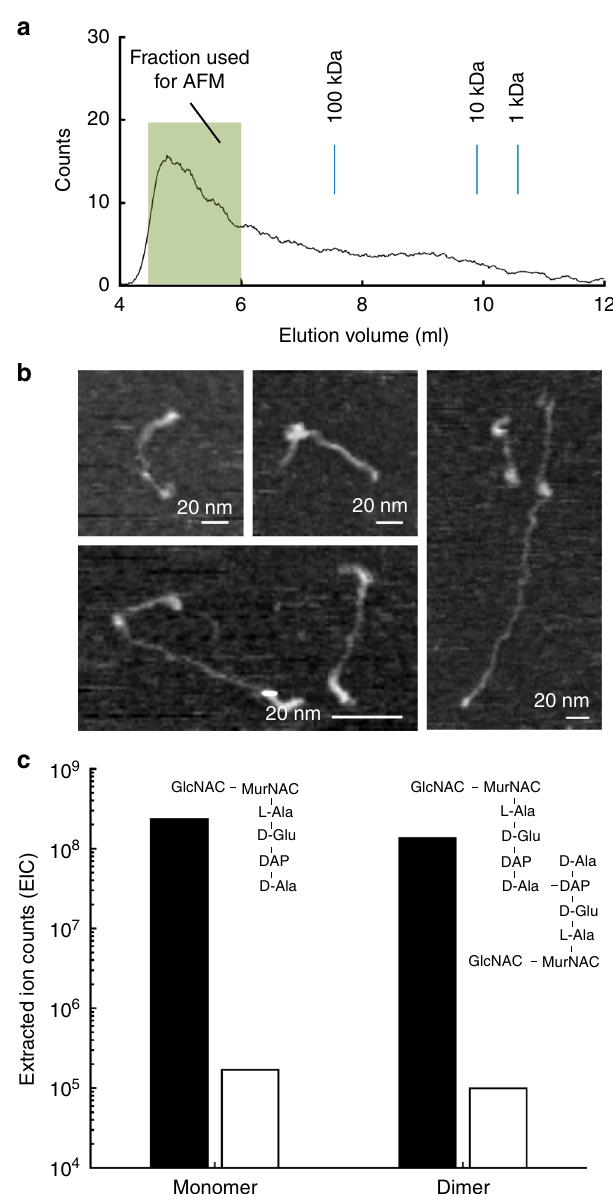
Fig. 3 Size exclusion chromatography and AFM imaging of isolated glycan strands. a Size exclusion chromatography trace of glycan chains from E. coli (MG1655). b AFM images of glycan chains from fraction shown in a (each panel adjusted for best contrast). c Sums of extracted ion counts (EIC) for positively charged adducts of the major peptidoglycan sugar-peptide monomer and dimer from material digested with either Cellosyl alone (black bars), or ATL amidase, then Cellosyl (white bars). Amidase treatment removes the cross-linking peptides, substantially reducing the abundance of sugar-peptide adducts and freeing the glycan